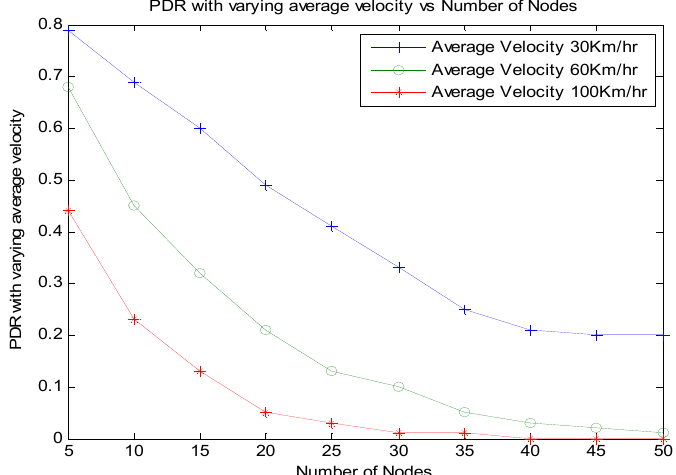
Figure 16. Effect of velocity on number of nodes in the zone. Figure 17 shows the average service processed for emergency messages. This parame- ter is measured as a factor of number of emergency messages processed out of the total number of emergency messages generated in the system. We have varied the emergency traffic as 20%, 50%, and 80% of the traffic from the network with nodes varying from 5 to 50. The results show that the emergency packets are serviced better than non-emergency packets, even if 80% of non- emergency packets exist in the system. When an equal number of emergency and non-emergency traffic exists, both types of traffic are initially considered. However, as the nodes increase, emergency packets are serviced more in all three scenarios.